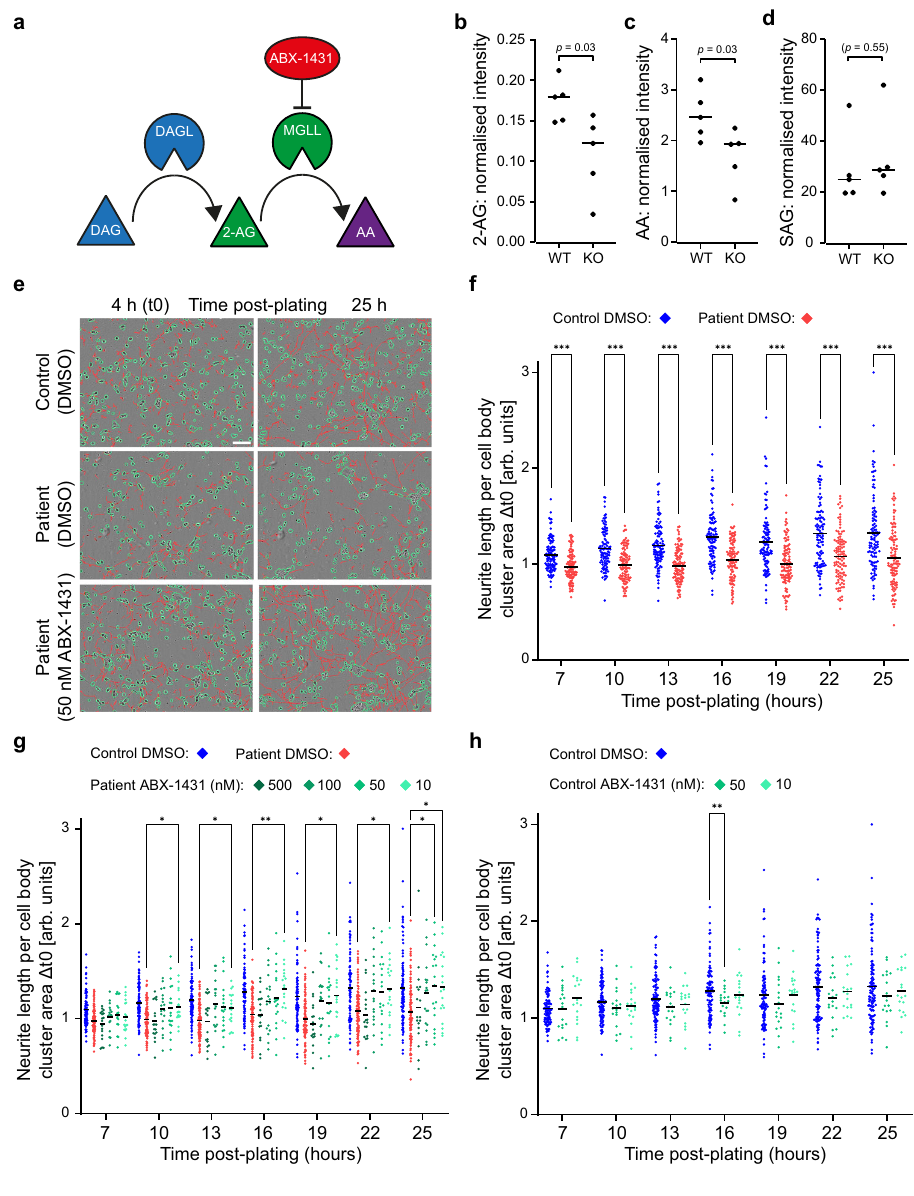
RRID:AB_10715072) and IRDye 800CW donkey anti-rabbit IgG (IR800CW, Cat# 926-32213, RRID:AB_621848), purchased from LI-COR Biosciences and used at 1:10000. Fluorescently labelled secondary antibodies used in this study were Alexa Fluor Plus 488-labelled goat anti-chicken IgY (Cat# A32931, RRID:AB_2762843), Alexa Fluor 488-labelled goat anti-guinea pig IgG (Cat# A-11073, RRI- D:AB_2534117), Alexa Fluor 488-labelled goat anti-mouse IgG (Cat# A-11029, RRID:AB_2534088), Alexa Fluor 594-labelled goat anti-mouse IgG (Cat# A11005, RRID:AB_2534073), Alexa-Fluor Plus 680-labelled donkey anti-mouse IgG (Cat# A32788, RRID:AB_2762831), Alexa Fluor 568-labelled donkey anti-rabbit IgG (Cat# A10042, RRID:AB_2534017), Alexa Fluor 647-labelled goat anti-rabbit IgG (Cat# A21245, RRID:AB_2535813), and Alexa Fluor 680-labelled donkey anti- sheep IgG (Cat# A-21102, RRID:AB_2535755), all purchased from Thermo Fisher Scienti fi c and used at 1:500. The speci fi city of antibodies against the key protein targets of this study (human DAGLB & ATG9A) was con fi rmed in-house using siRNA-mediated knockdown in HeLa cells, by Western blotting (loss of band of expected size) and immuno fl uorescence microscopy (loss of fl uorescent signal). The anti-ATG9A antibody is KO-validated by the manufacturer (Abcam). Fluor- escently labelled secondary antibodies were con fi rmed to be speci fi c through no primary antibody controls. The other primary antibodies, used as cellular markers, were not validated.